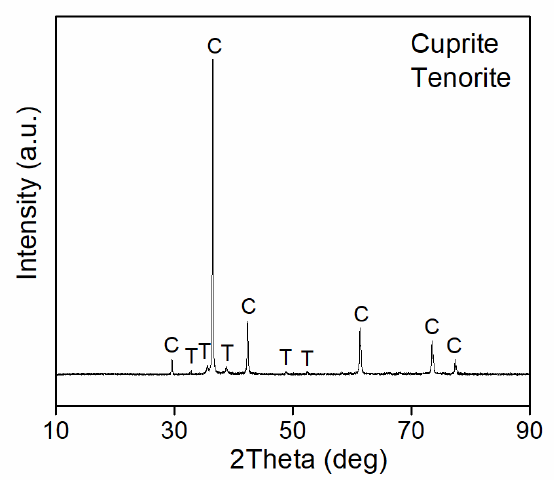
Figure A2. XRD result for burned copper. Cuprite (C) and tenorite (T) were identified.